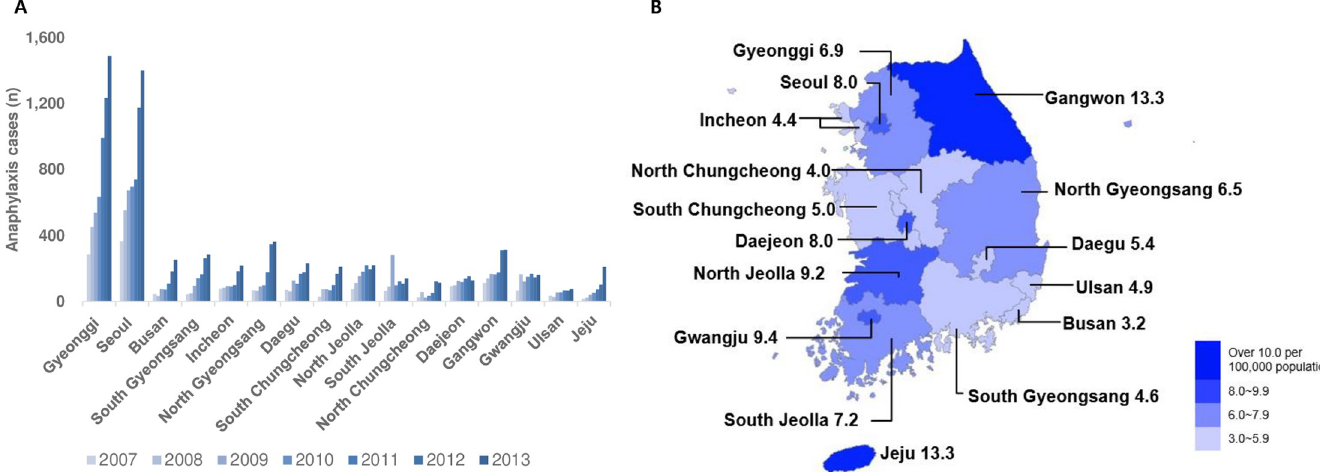
Fig 2. Regional distribution of anaphylaxis cases through 2007–2013. (A) Annual anaphylaxis cases by region. The names of the regions are in order of the highest mid-population. (B) The map of anaphylaxis cases per 100,000 populations. (Statistical Geographic Information Service (SGIS, http://sgis.kostat.go.kr)).